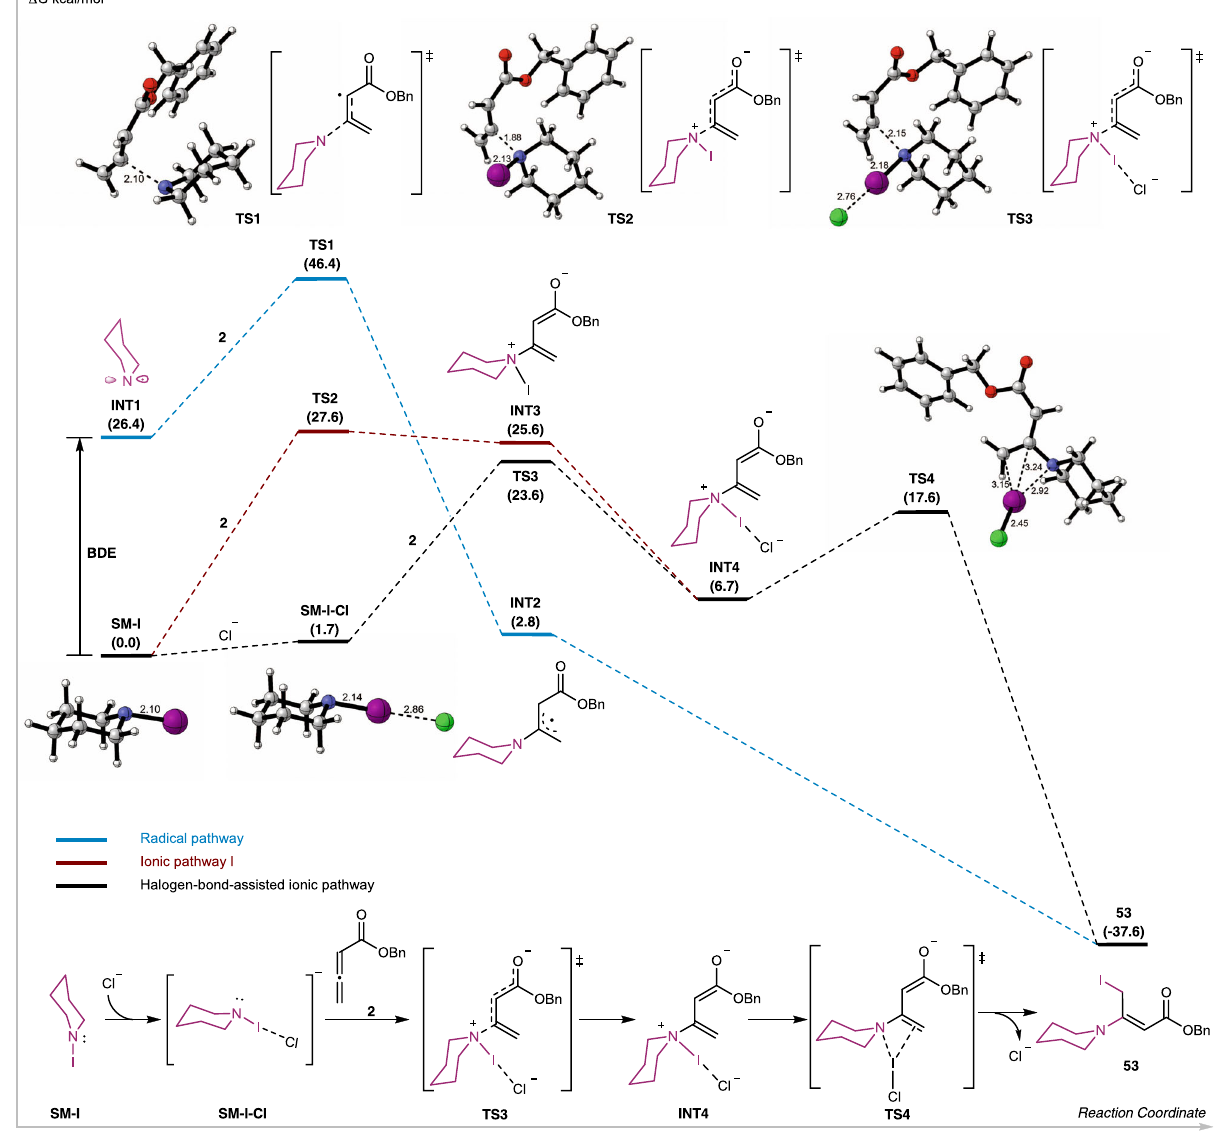
Fig. 6 | Computational studies. Free energy pro fi les (kcal/mol) of the radical and ionic processes for the formation of 53 at the Mo6-2x-D3/def2-TZVPP (SMD18, acetonitrile) //M06-2x-D3/def2-SVP (SMD18, acetonitrile)